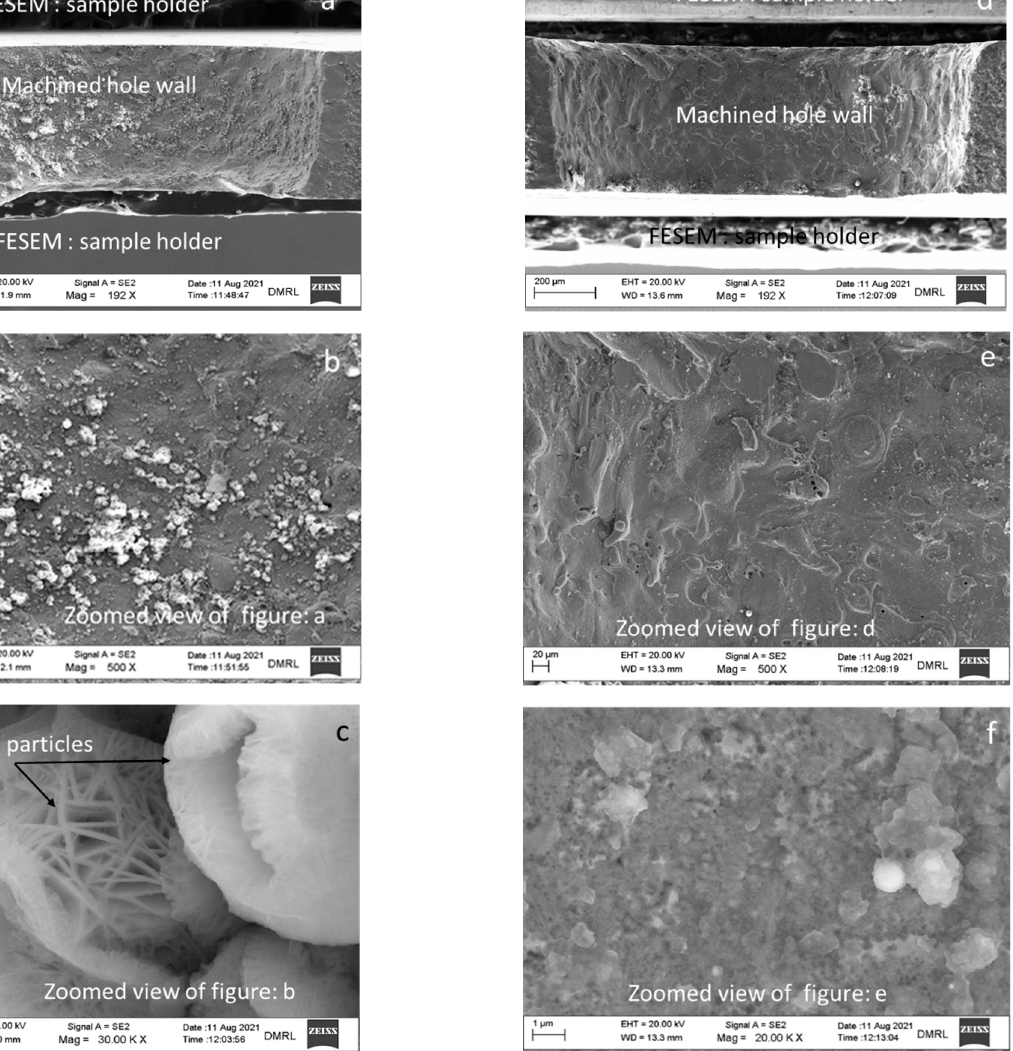
Figure 7. FESEM images of hole wall fabricated by ( a – c ) MECDM process and ( d – f ) PMECDM pro- cess (parameter settings: Applied voltage: 40 V, duty factor: 20%, electrolyte concentration: 20 wt%).